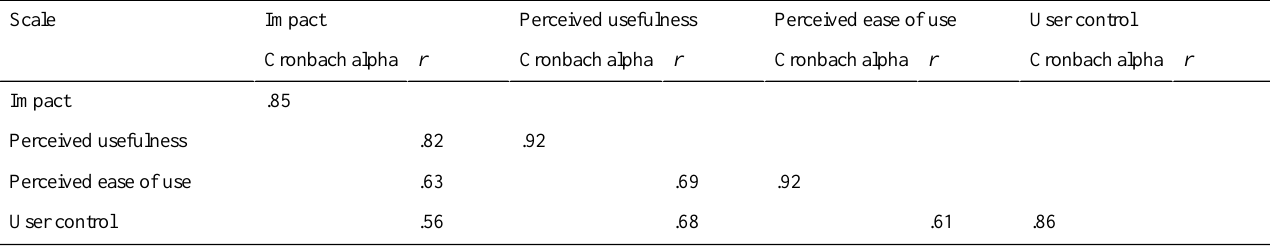
User controlPerceived ease of usePerceived usefulnessImpactScale